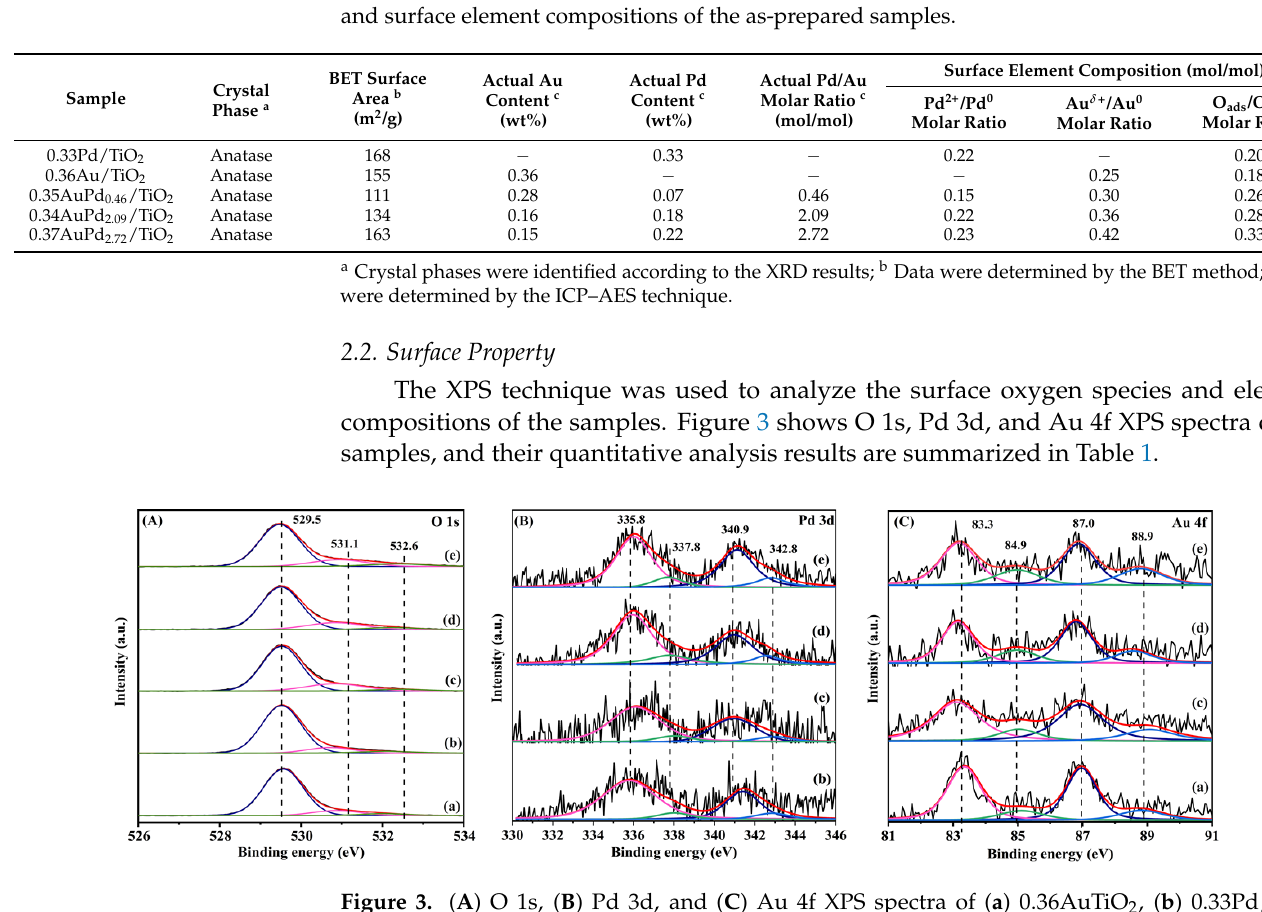
Table 1. Crystal phases, BET surface areas, actual noble metal contents, actual Pd/Au molar ratios,